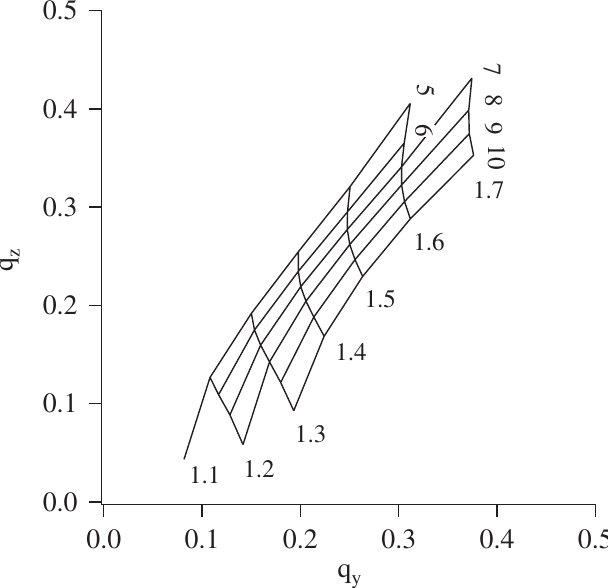
FIG. 5. Phase advance = 2 (cid:2) in a unit cell with different ð field index k Þ =y and ratio of field strength at F and D . 0 Upright numbers indicate the ratio of the field strength, (cid:1) B =B and vertically aligned numbers indicate the z 0 ;D z 0 ;F ð field index k Þ =y . 0